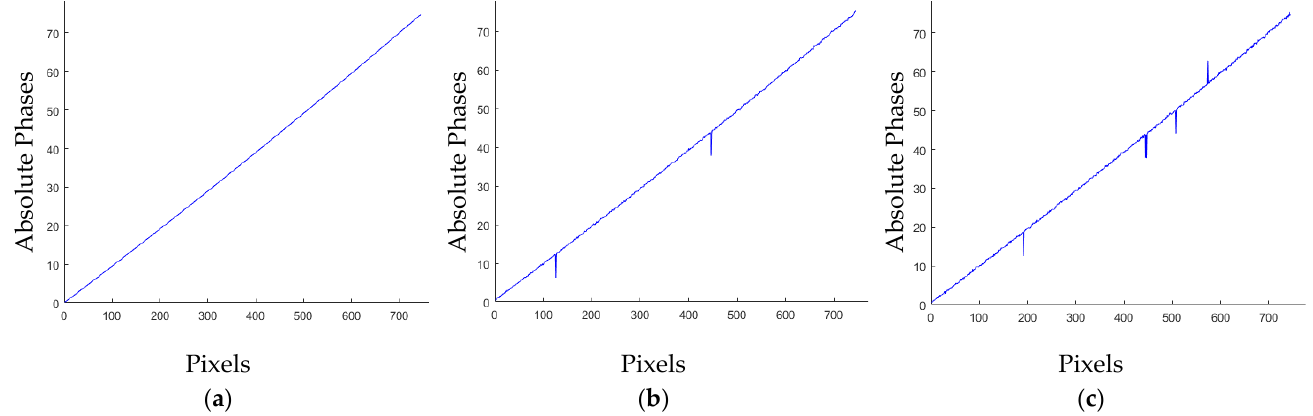
Figure 4. Phase unwrapping by the method of this paper under different noises. Phase expansion by the method of this paper when no Gaussian noise is added ( a ). The phase expansion is performed by the method of the this paper when adding the first set of Gaussian noise ( b ). The phase expansion is performed by the method of the this paper when adding the second set of Gaussian noise ( c ).